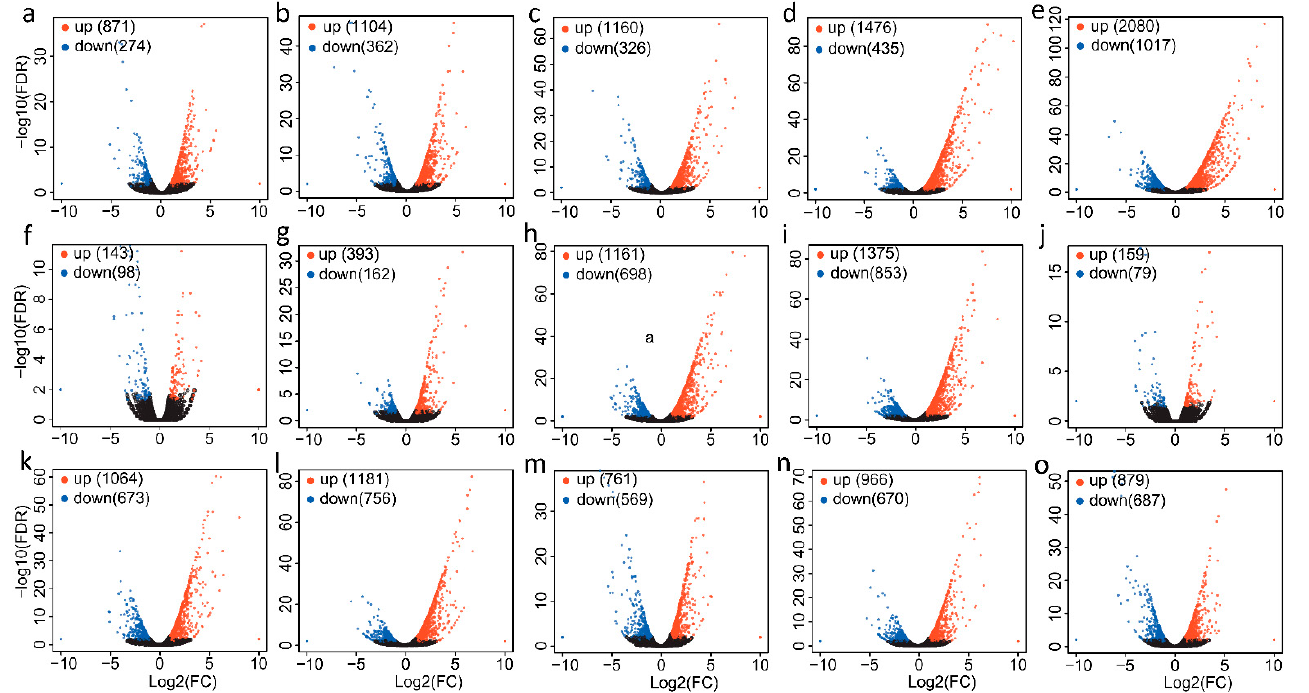
Figure 2. Volcano-plots of cold-induced DEGs. ( a ) 3 h vs. CK (0 h); ( b ) 6 h vs. CK; ( c ) 9 h vs. CK; ( d ) 12 h vs. CK; ( e ) 24 h vs. CK; ( f ) 6 h vs. 3 h; ( g ) 9 h vs. 3 h; ( h ) 12 h vs. 3 h; ( i ) 24 h vs. 3 h; ( j ) 9 h vs. 6 h; (k) 12 h vs. 6 h; ( l ) 24 h vs. 6 h; ( m ) 12 h vs. 9 h; ( n ) 24 h vs. 9 h; ( o ) 24 h vs. 12 h. The abscissa is the fold change value of the gene or transcript expression difference between two samples (sample 1/sample 2), and the ordinate is the statistical test value of the difference in gene or transcript expression change; that is, the higher the p -value, the more significant the difference in expression. The values of the abscissa and ordinate are all logarithmic. Each dot in the figure represents a specific gene or transcript; the red dots represent significantly up-regulated genes, the blue dots represent significantly down-regulated genes, and the black dots represent non-significant differential genes. The dots on the left represent differentially down-regulated genes, and the dots on the right are genes whose expression is differentially up-regulated.